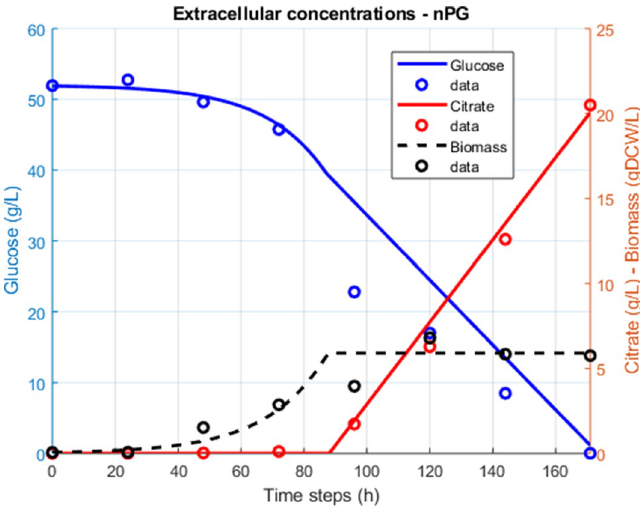
Figure 6. Inhibition of AOX activities by nPG triggers citrate production experimentally (n = 1) and in silico. Up to 20 g/L of citrate is produced during the